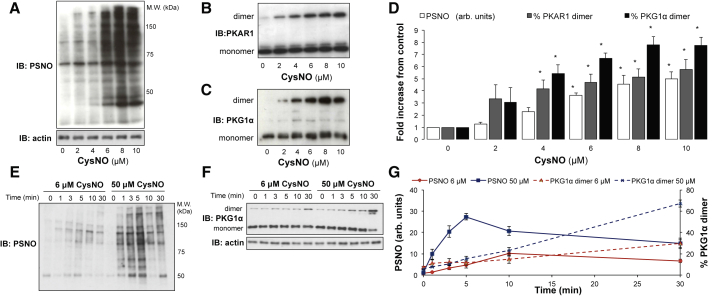
Disulfide Formation Is Observed before an Increase in Detectable S-Nitrosothiols(A–C) SMCs treated with increasing doses of CysNO for 30 min were analyzed for protein S-nitrosothiol (PSNO) content using the biotin switch method. A dose-dependent increase in PSNO (A) was observed as well as a concurrent increase in PKAR1 (B) and PKG1α (C) disulfide dimer.(D) A significant increase in disulfide dimer formation in both proteins was observed before a significant change in detectable PSNO.(E and F) PSNO and PKG1α formation measured by immunoblotting over a time course of 30 min after SMCs were treated with 6 or 50 μM CysNO.(G) PSNO peaked at 10 and 5 min, respectively, before decreasing in abundance, whereas the PKG1α disulfide dimer increased with time.Data are represented as mean ± SEM; ∗p < 0.05.